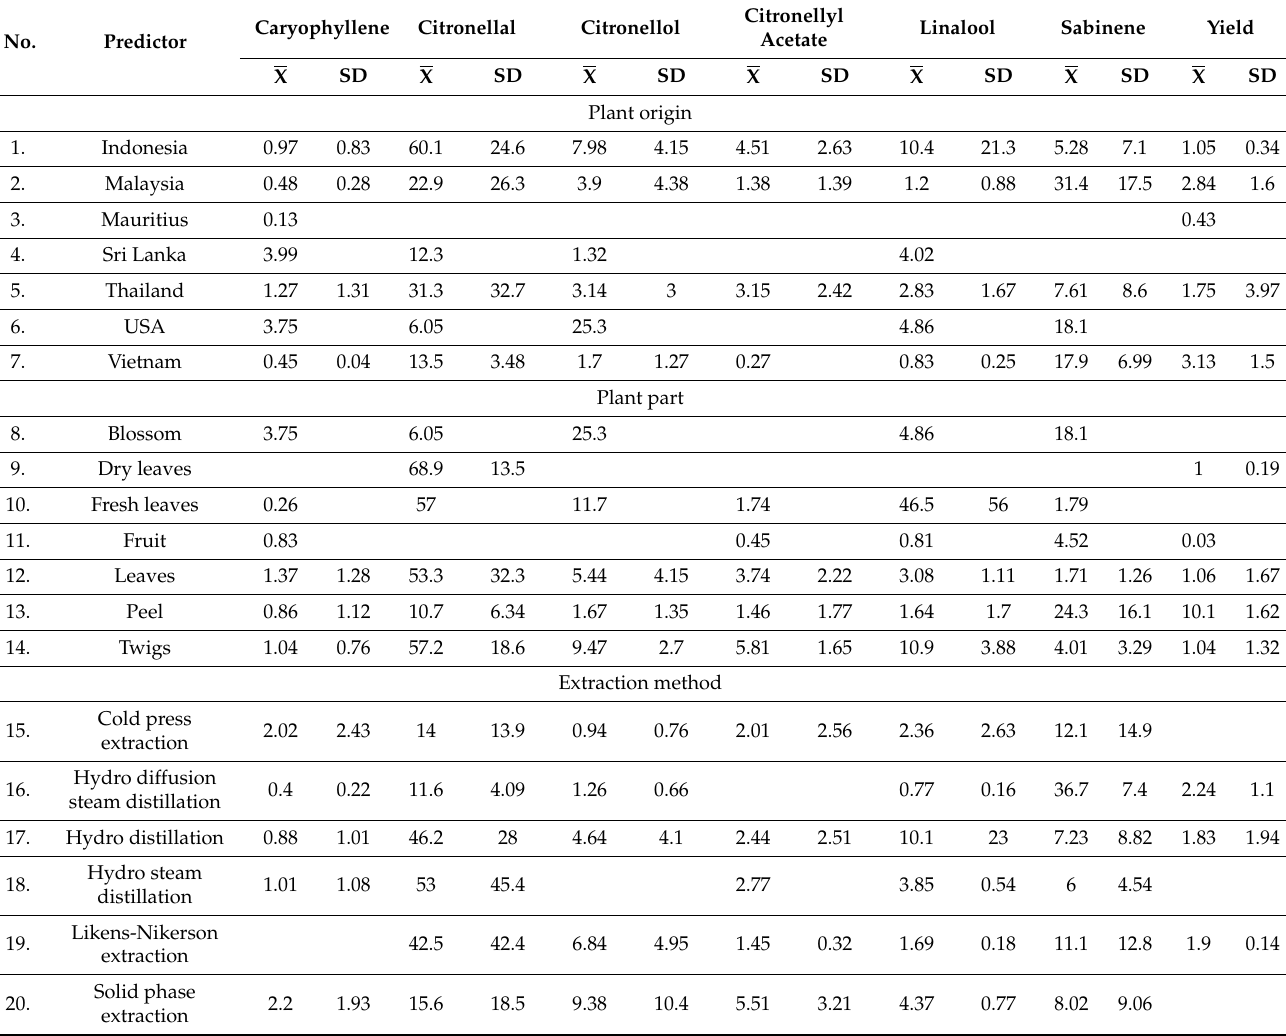
Table 3. Mean (X) and standard deviation (SD) based on plant origin, plant part, and extraction